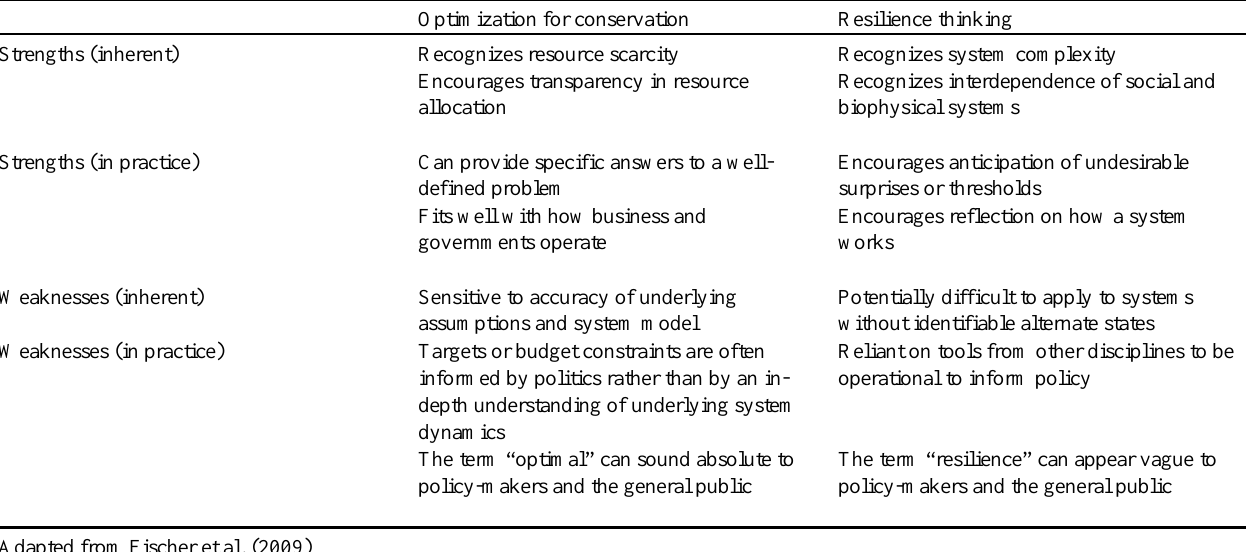
Table 2 . Optimization and resilience